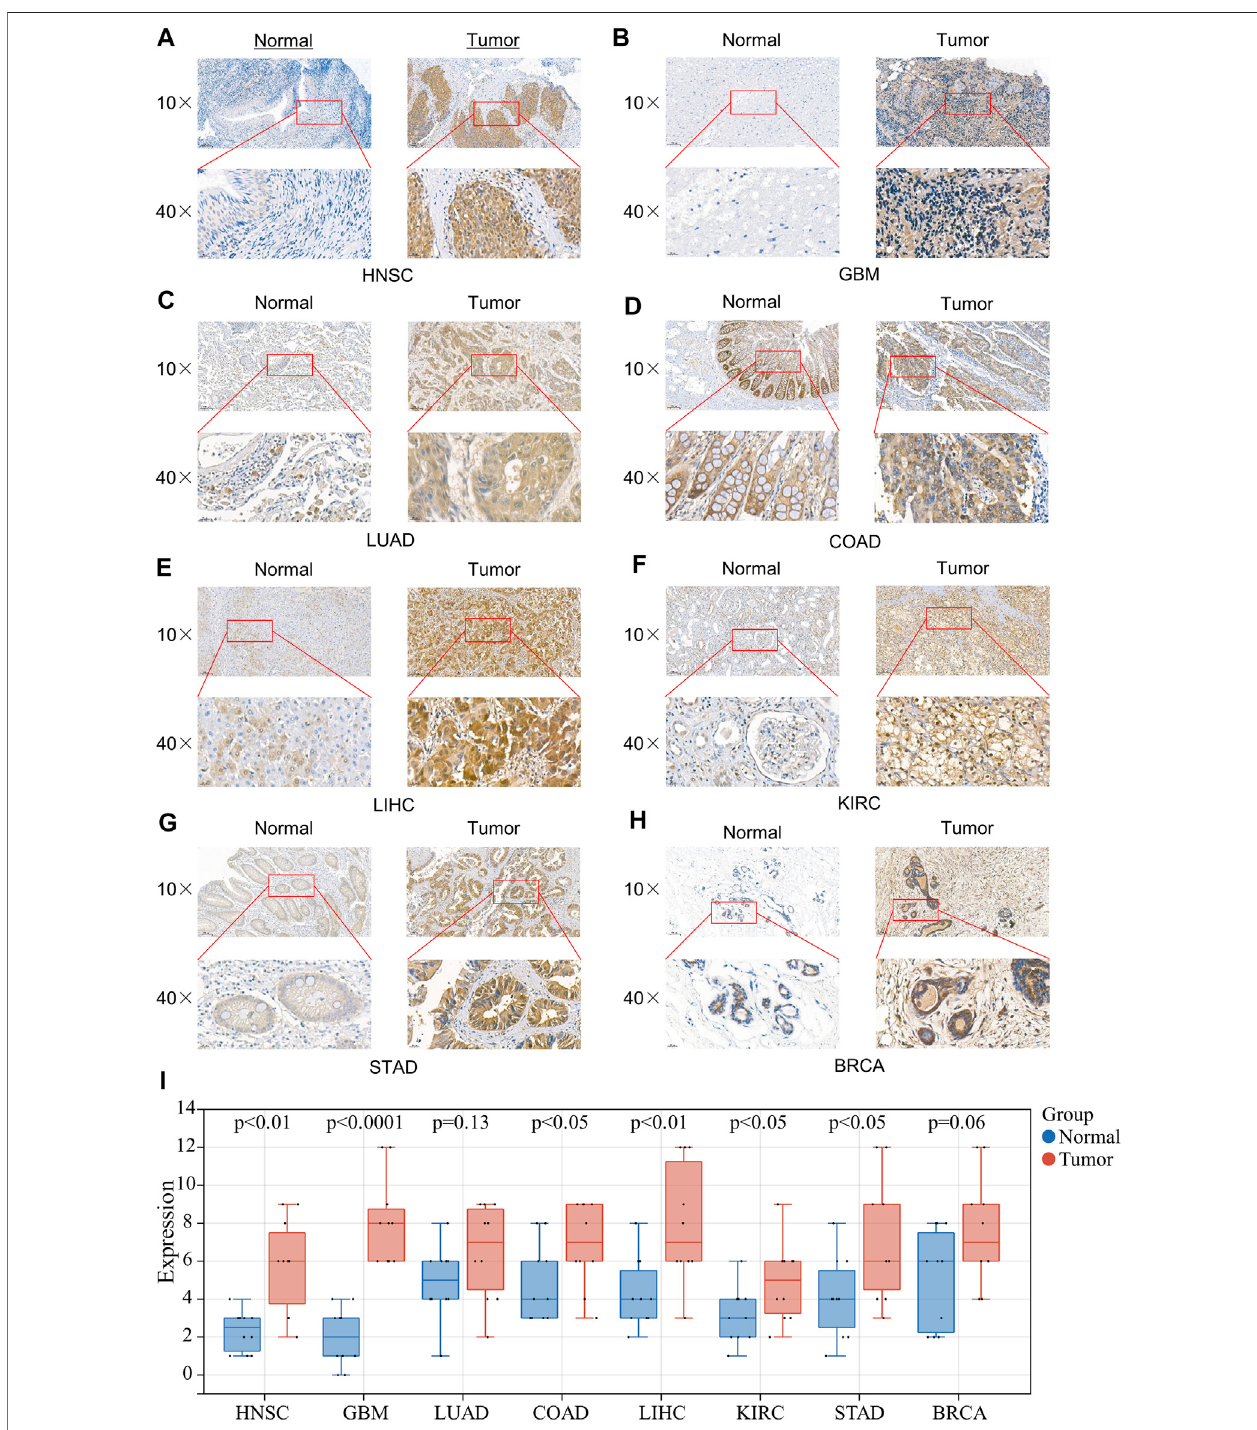
FIGURE 7 | Expression of 4EBP1 in clinical specimens of multiple cancers. Representative images of 4EBP1 (brown, cell cytoplasmic/nucleus stain) IHC of (A) HNSC (Nasopharyngeal Carcinoma), (B) GBM, (C) LUAD, (D) COAD, (E) LIHC, (F) KIRC, (G) STAD, and (H) BRCA. (I) IHC quanti fi cation and comparison results between cancer and adjacent tissues ( t